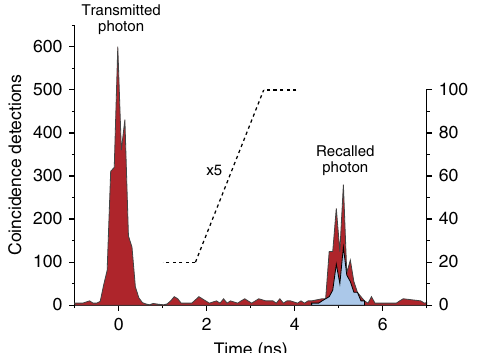
Figure 3 | Reversible mapping of broadband and heralded single Figure 4 | Quantum storage with large time-bandwidth product. photons. Heralded telecom-wavelength photons, centred at 1,532.7nm 16-GHz-wide AFC regions with teeth spacing ranging from 200 to 20MHz wavelength and having a bandwidth of 50GHz, are mapped onto the AFC are subsequently programmed to store heralded single photons for 5–50ns. memory and recalled after time t storage ¼ 1 ¼ 5ns. The histogram shows D The histograms show measured coincidence rates for recalled photons for time-resolved coincidence detections collected over 3min. Owing to non- each storage time, and the dashed diamonds depict the corresponding unit absorption probability by the AFC as well as bandwidth mismatch memory efficiencies (see Supplementary Note 3 for details). Note that in between the spectra of the photons and the AFC, a significant portion of the this figure and henceforth the transmitted pulse at t ¼ 0 exceeds the input photons is directly transmitted and detected at zero delay. The light vertical scale and thus is capped at the top. Experimentally obtained g ð 2 Þ blue highlighted section bounded by a dotted line in the trace of the recalled photon (counts scaled by a factor of five) corresponds to the measurement each storage time are shown in the inset. The measurement time varied in which the total AFC bandwidth was 8GHz; the red section corresponds between 5 and 15min. All error bars are standard deviations derived from to a measurement using a 16-GHz-wide AFC. Poissonian counting